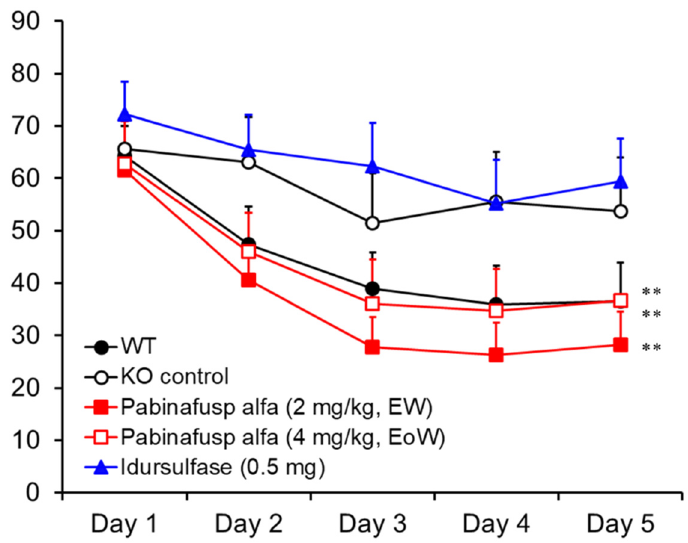
Figure 4. Maintenance of spatial learning abilities in MPS II mice receiving chronic treatment with pabinafusp alfa. After 36 weeks of treatment, spatial learning ability was assessed with the Morris water maze test. The time to reach the platform (goal latency) was measured 3 times per day and the means were calculated within each day for individual animals. Values are presented as the mean with S.E. for each group ( n = 12–15). Paired t-test, ** p < 0.01 (Day 1 vs. Day 5). EW, every week; EoW, every other week. Reproduced from [20].